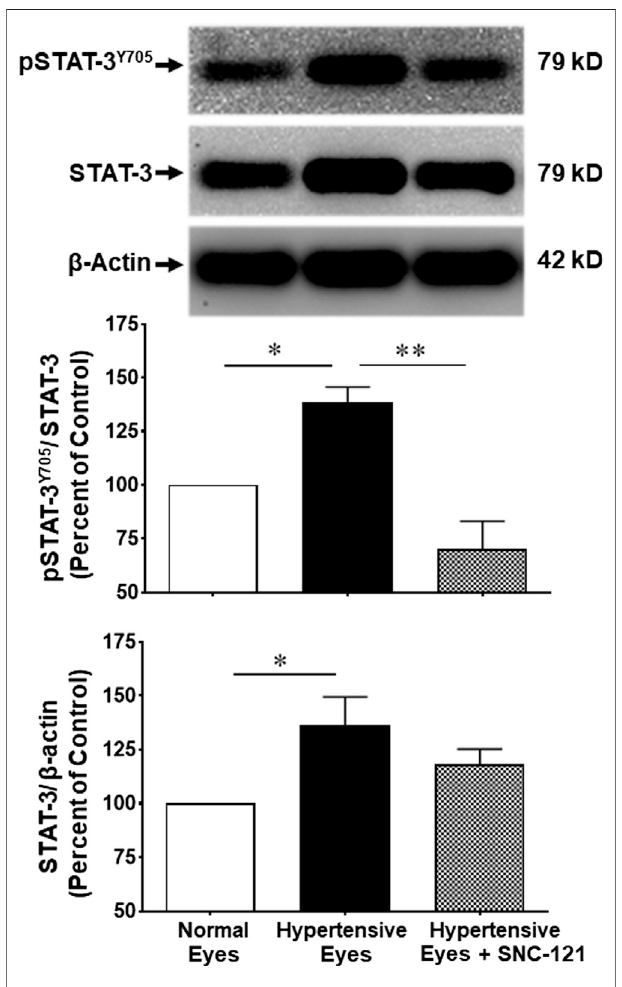
FIGURE4| ChangesinthephosphorylationofSTAT3(Tyr705)andtotal STAT3 by SNC-121 treatment in ocular hypertensive animals. The retina from normal, ocular hypertensive, and SNC-121 treated ocular hypertensive animals were collected at day 7, post hypertonic saline injection. Equivalentamountofretinaproteinextracts(20 μ g)wereanalyzedbyWestern blotting using aselectiveanti-phosphoSTAT3(Tyr 705), anti-STAT3, and anti- β -actin antibodies. The band intensities were measured using enhanced chemiluminescence reagent and Versadoc imaging system. Bar graph represents mean data ± SEM. OH Eyes; ocular hypertensive eyes; OH Eyes + SNC-121, ocular hypertensive eyes with SNC-121 treatment. * p < 0.05; **** p < 0.0001; n (cid:2) 6 – 9. In this experiment “ n ” represent a biological replicate.